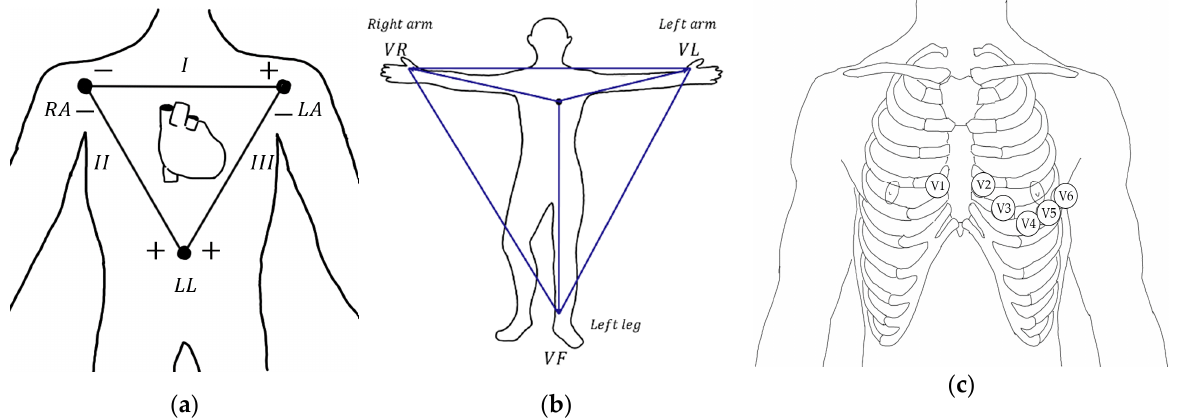
Figure 6. ( a ) Standard limb leads, ( b ) augmented limb leads, ( c ) precordial leads (V1: fourth intercostal space (ICS), right margin of the sternum; v2: fourth ICS along the left margin of the sternum; v4: fifth ICS, mid-clavicular line; v3: midway between v2 and v4; v5: fifth ICS, anterior axillary line (same level as v4); and v6: fifth ICS, mid-axillary line (same level as v4)).